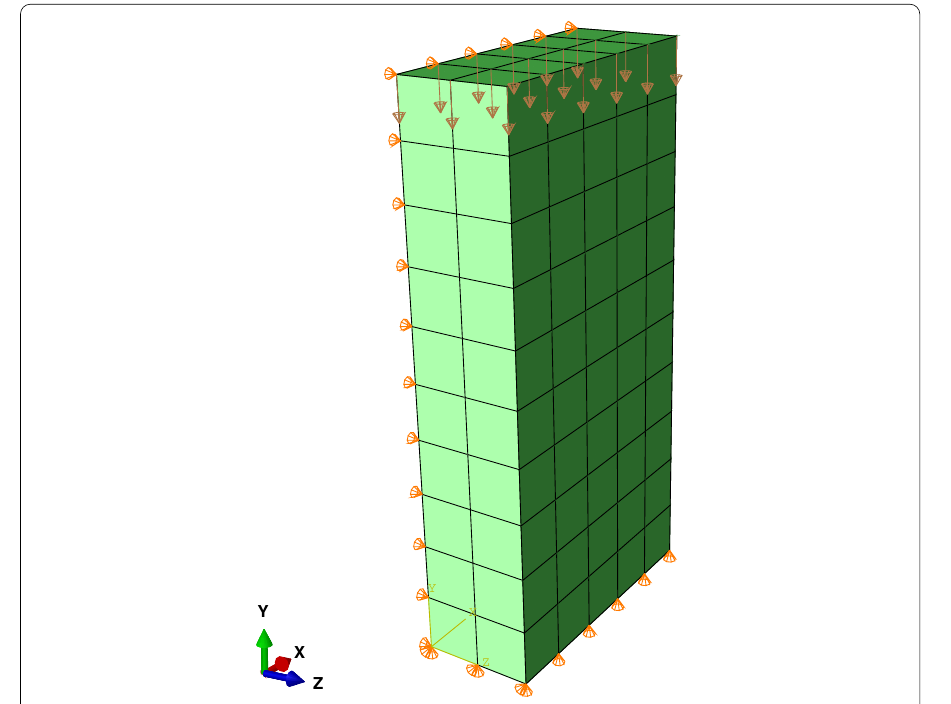
Fig. 9 Medium mesh and boundary conditions for a compression